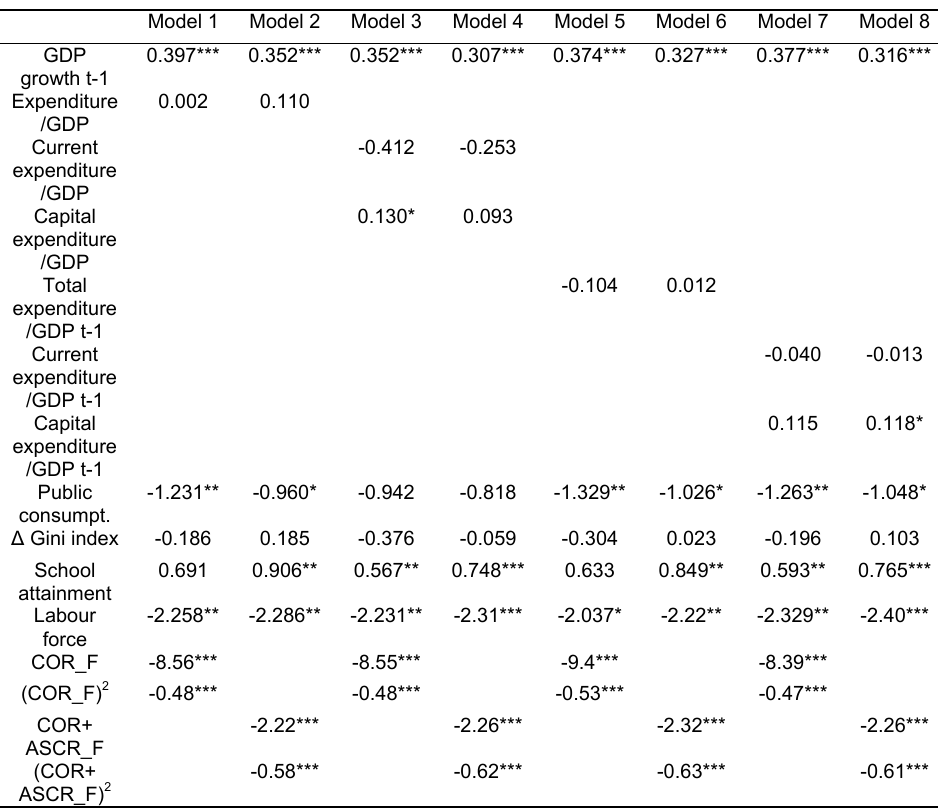
Table 5. Estimates of Equation 2, disaggregated